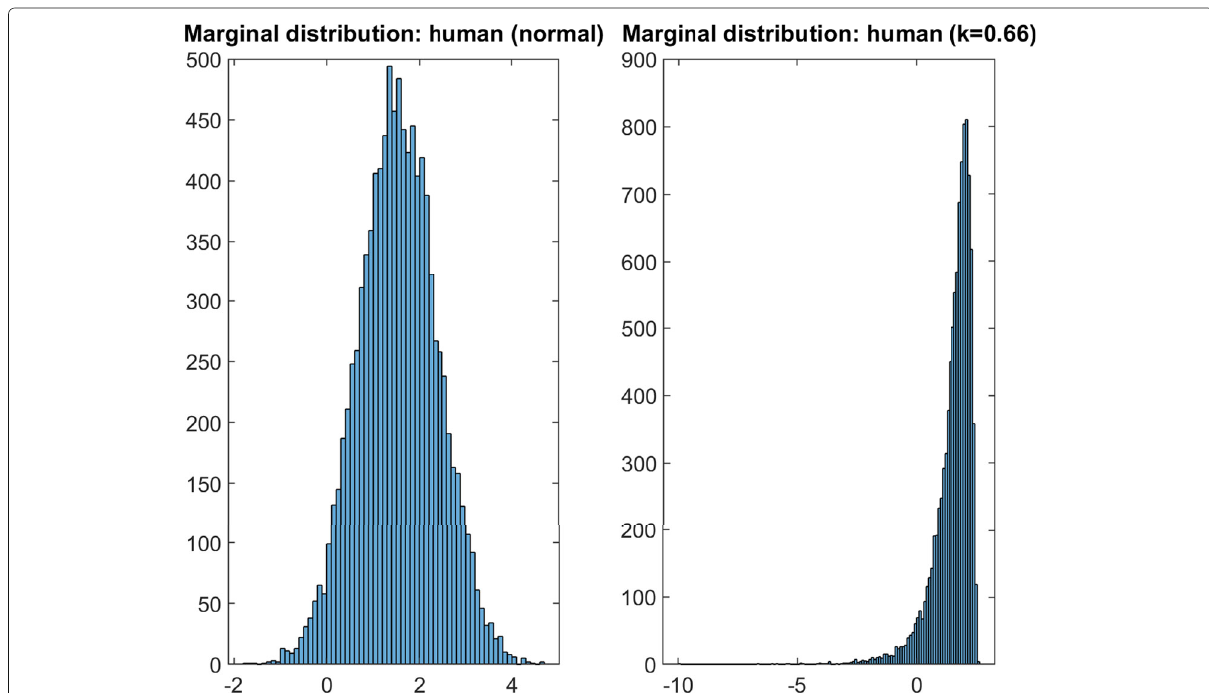
Fig. 5 Distribution Transform: Histograms of marginal distributions of the ’Human’ value for the normal dataset (left) and one of the transformed datasets